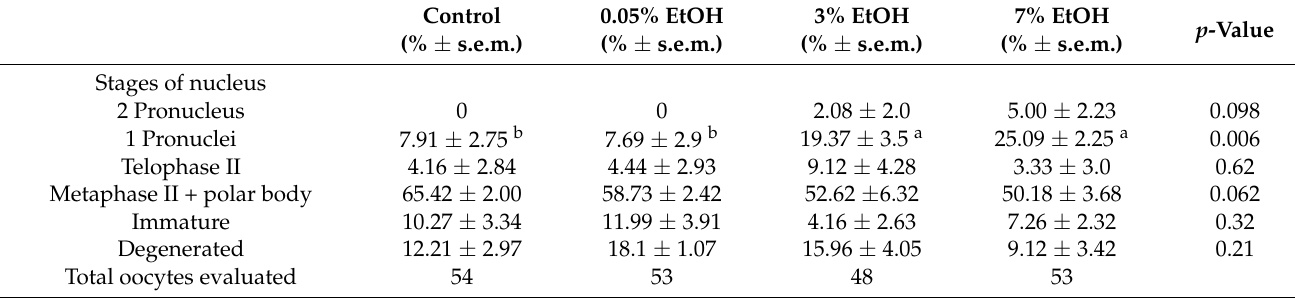
Table 3. Percentages (% ± s.e.m.) of pronucleus formation, telophase II, metaphase II + polar body, immature (germinal vesicle, metaphase I, anaphase I, telophase I) and degenerate in bovine oocytes cultured for 22 h (IVF-TL) in absence of spermatozoa and after of in vitro maturation without (control) or with ethanol at 0.05% for 24 h or activated with ethanol at 3% or 7% for 7 min.